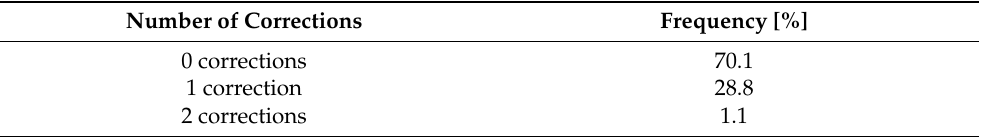
Table 3. Fraction of batches undergoing corrections over one year of plant operation after the